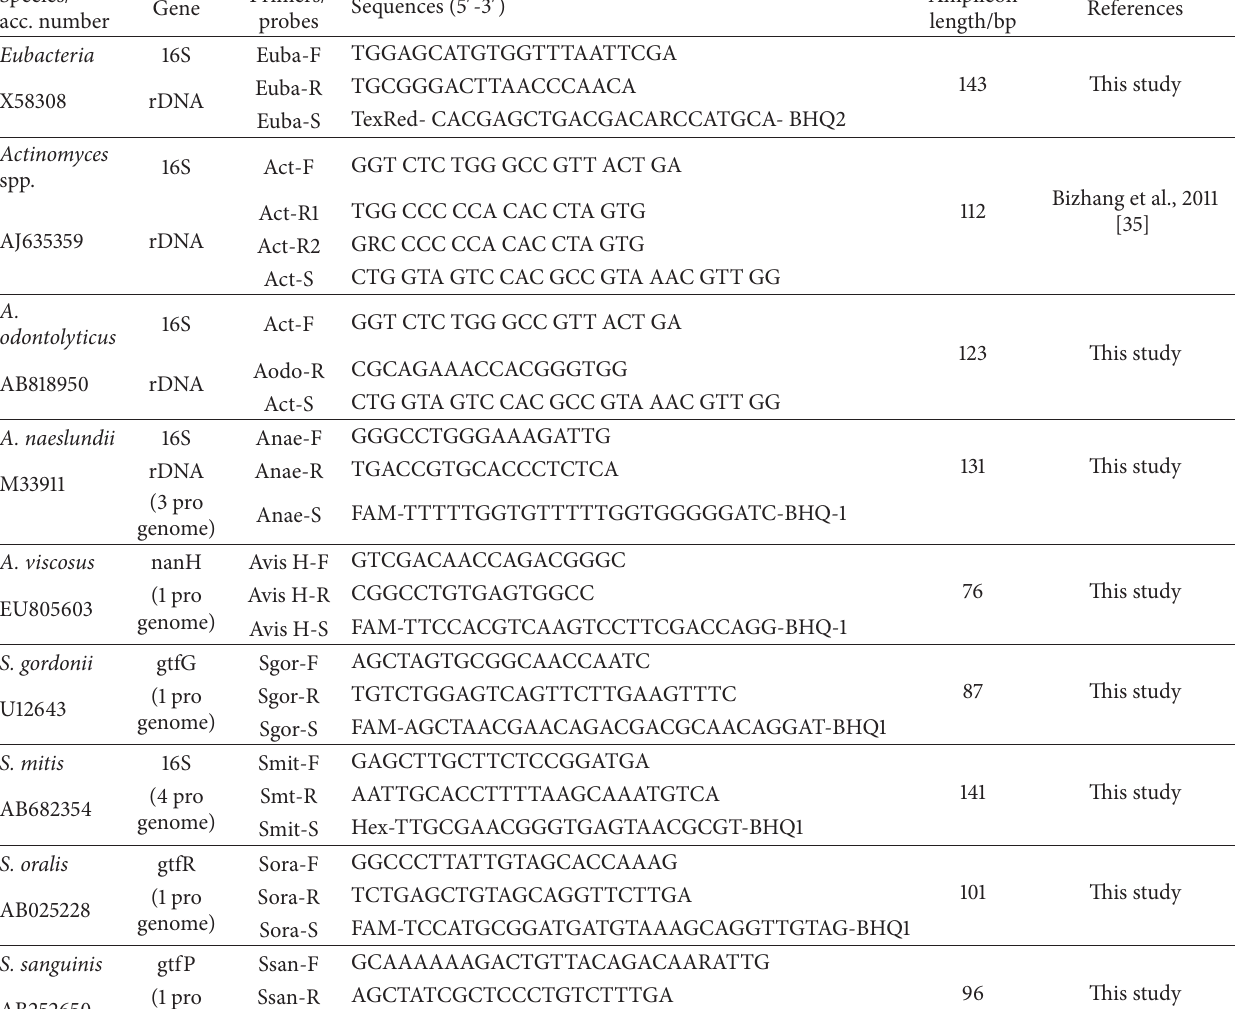
Table 4: Design of the specific primers and